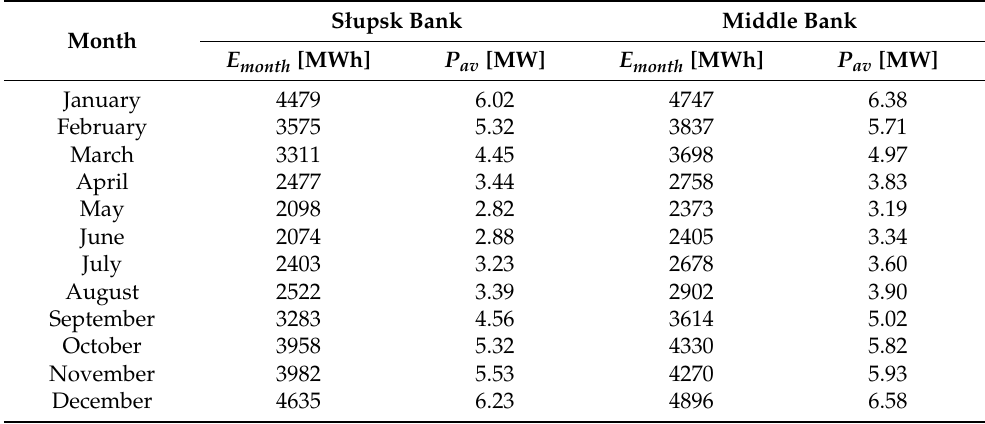
Table 6. Forecast of energy generation and electric power in individual months of the non-leap year.